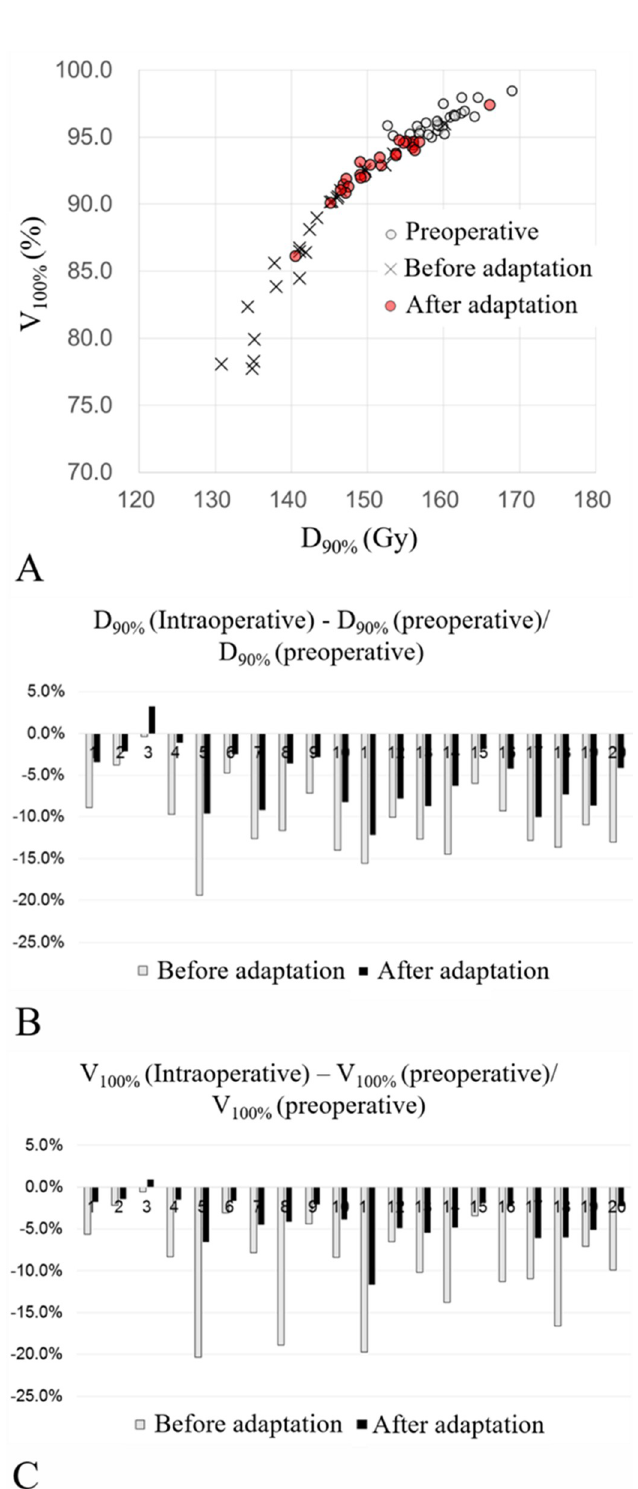
Fig 5. (A) D90% and V145 Gy for preoperative planning, before and after intraoperative optimization. (B) The difference between the intraoperative and preoperative plan in D90% was divided by the preoperative D90%. (C) The difference between the intraoperative and preoperative plan in V145 Gy was divided by the preoperative V145 Gy. In (B) and (C), light bars indicate the calculated value before optimization and dark bars indicate the calculated value after